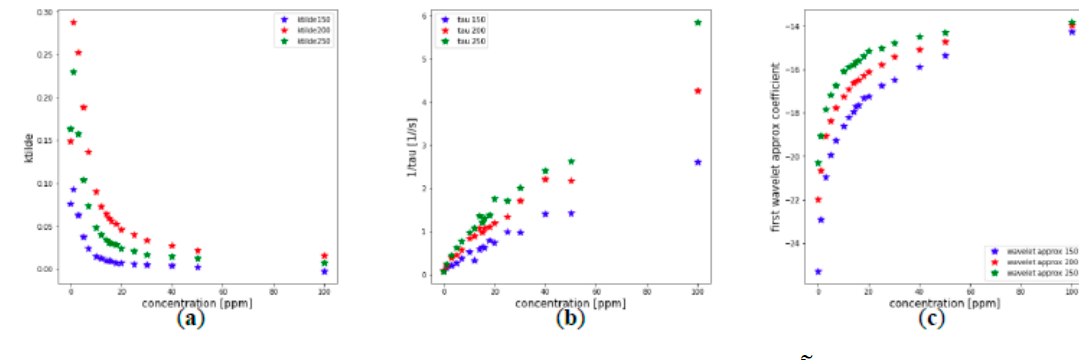
Figure 3. Features plotted versus various CO concentrations ( a ) Feature: ; ( b ) Feature: 1/ τ ; ( c ) Feature: first wavelet approximation